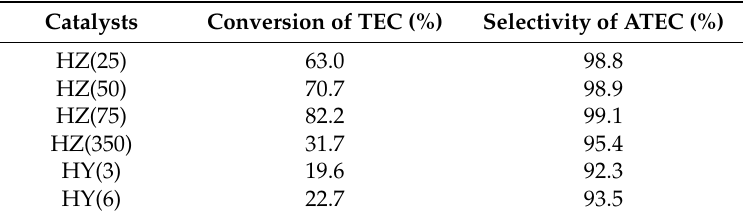
Table 2. Catalytic activities of the acid catalysts in the acetylation of TEC.